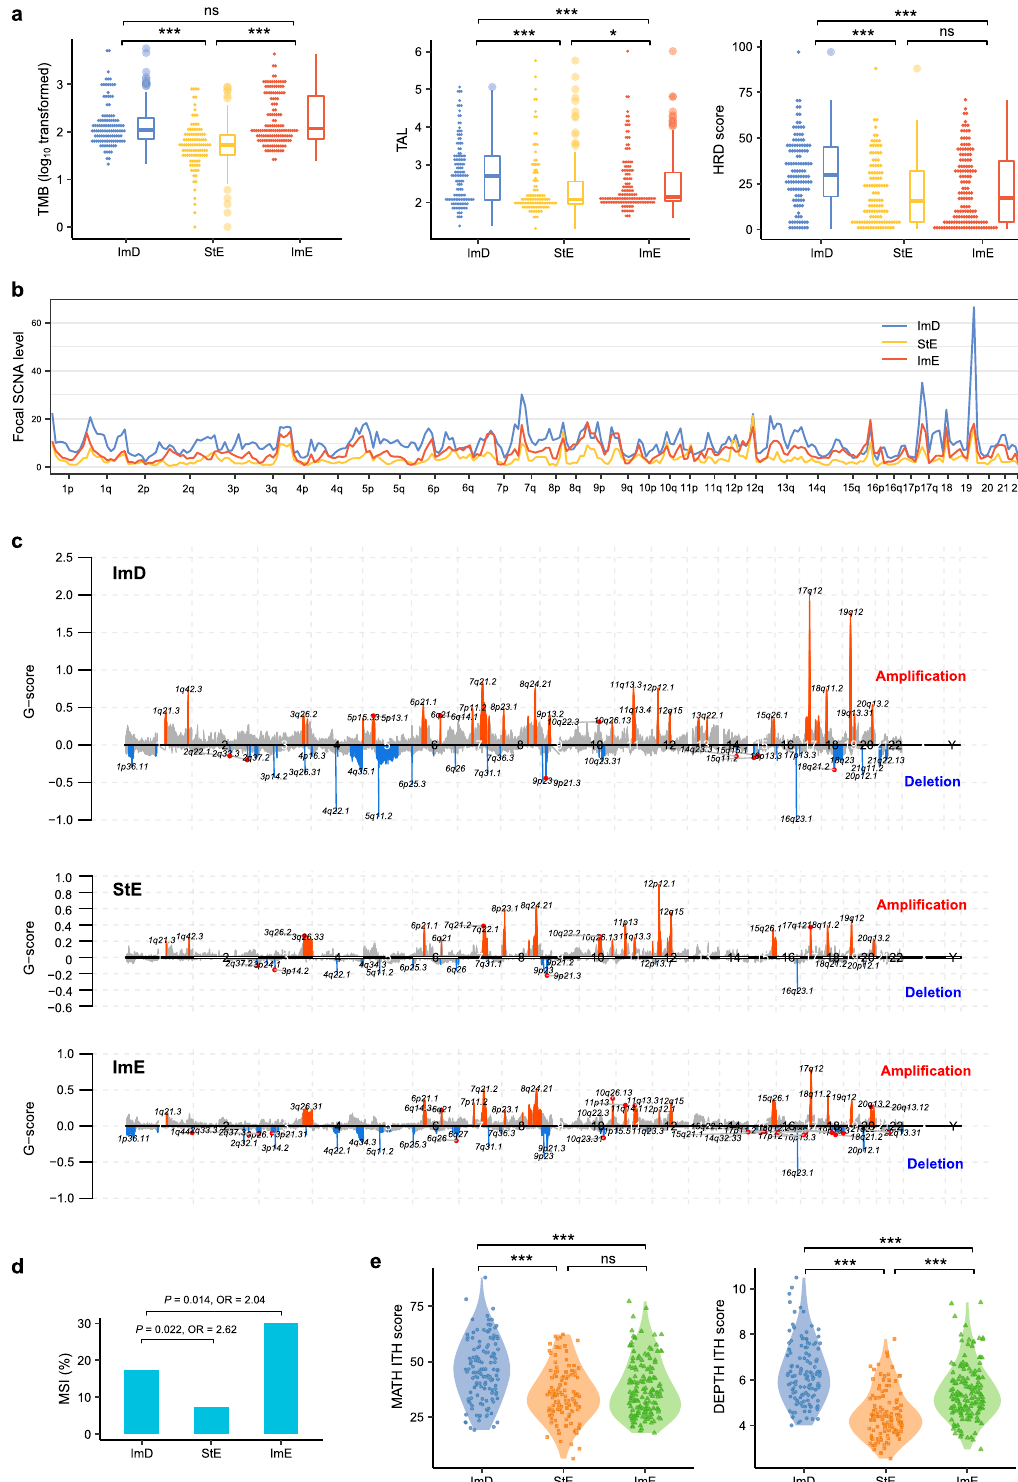
Fig. 3 Comparisons of genome instability and intratumor heterogeneity between the three GC subtypes in TCGA-STAD. a Comparisons of TMB, TAL, and HRD scores between the three GC subtypes. b , c ImD and StE have the highest and lowest levels of SCNAs, respectively. The SCNA levels and G -scores were calculated by GISTIC2 98 . d ImE and StE harbor the highest and lowest proportion of MSI cancers, respectively. The Fisher ’ s exact test P values and odds ratios are shown. e ImD and StE display the highest and lowest ITH, respectively. The one-tailed Mann – Whitney U test P values are indicated in ( a ) and ( e ). The MATH 96 and DEPTH 97 algorithms were used to evaluate ITH at the DNA and mRNA levels, respectively. TMB tumor mutation burden, TAL tumor aneuploidy level, HRD homologous recombination de fi ciency, SCNAs somatic copy number alterations, OR odds ratio, ITH intratumor heterogeneity, ns, not signi fi cant, * P < 0.05, ** P < 0.01, *** P < 0.001. Published in partnership with The Hormel Institute, University of Minnesota npj Precision Oncology (2021)